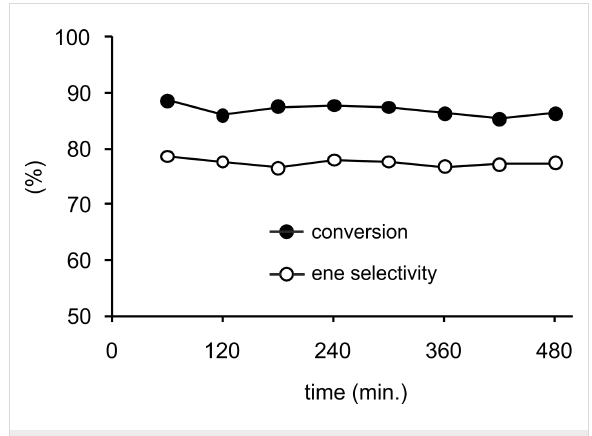
Figure 8: Conversion and selectivity vs. time-on-stream for the continuous-flow hydrogenation of 6 over Pd@MonoBor